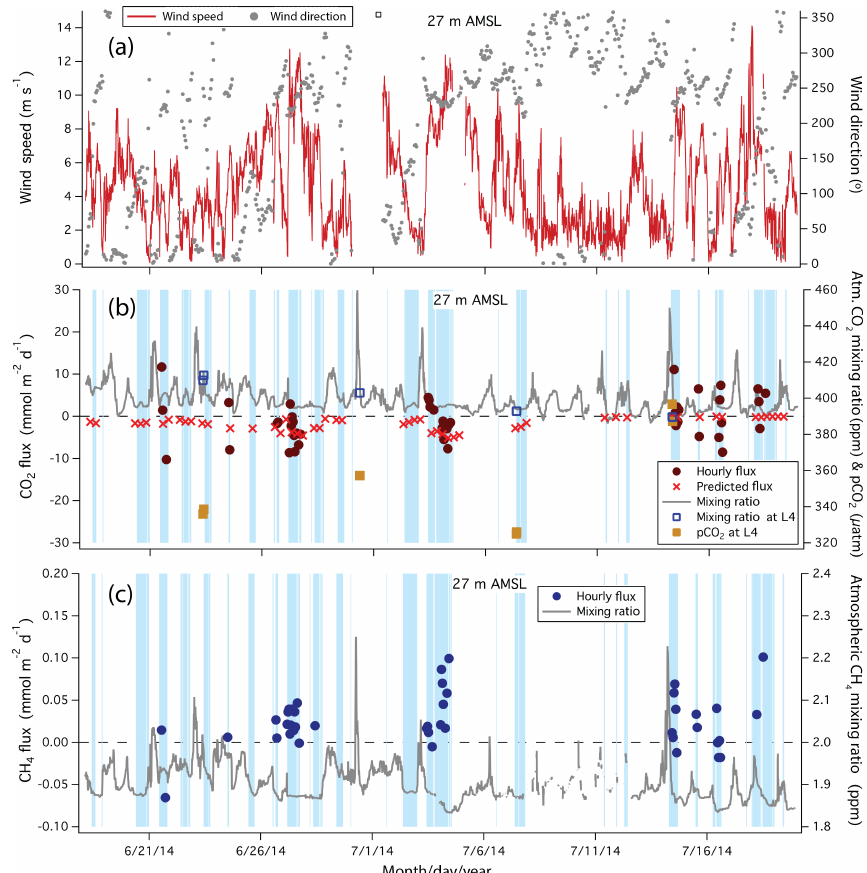
Figure 10. Time series of (a) wind speed and direction, (b) CO 2 flux and mixing ratio, and (c) CH 4 flux and mixing ratio during June– July 2014 (sampling height of 27ma.m.s.l.). Cyan shading indicates onshore winds. Fluxes are limited to the south-west wind sector only. Also shown are p CO 2 and atmospheric CO 2 mixing ratio from the L4 station. Negative CO 2 fluxes on the order of a few mmolem − 2 d − 1 were observed during the windy periods on 27 June and 4 July. By late July, observed CO 2 fluxes were indistinguishable from zero, consistent with near saturation of seawater p CO 2 at the L4 station. CH 4 flux has a positive mean, suggesting sea-to-air